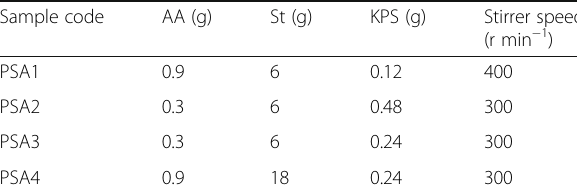
Table 2 Recipes of PSA nanospheres Sample code